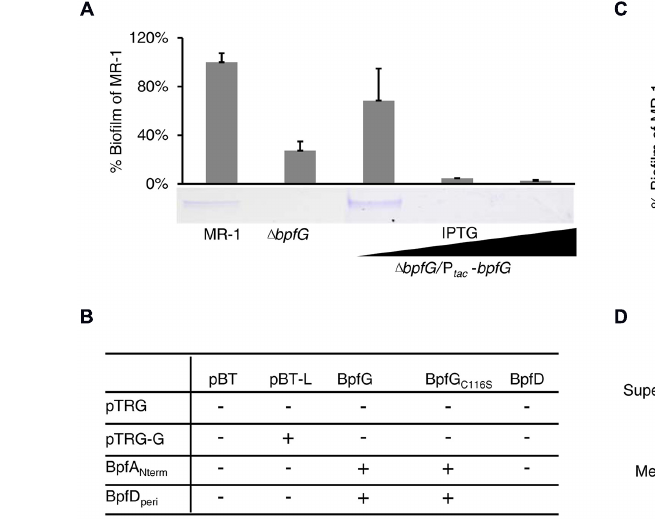
domain ( ∼ 100 a.a.) of BpfD, see Section “Materials and Methods” for more explanations. (C) Comparison of wild-type BpfG (dark gray) with BpfG C15S (light gray) and BpfG C116S (gray) in their ability to complement (cid:2) bpfD for biofilm formation. The wild-type and (cid:2) bpfD were provided for reference. P tac recombinant plasmids were treated with different concentrations of IPTG. Error bar represents SE of three experiments. BpfG C18S and BpfG C28S displayed similar phenotype as BpfG C15S and were omitted in the figure for simplicity. (D) BpfA from the extracellular and membrane preparations of indicated strains were visualized by protein electrophoresis. Gels separated by a black line were from samples derived from the same experiment and processed in